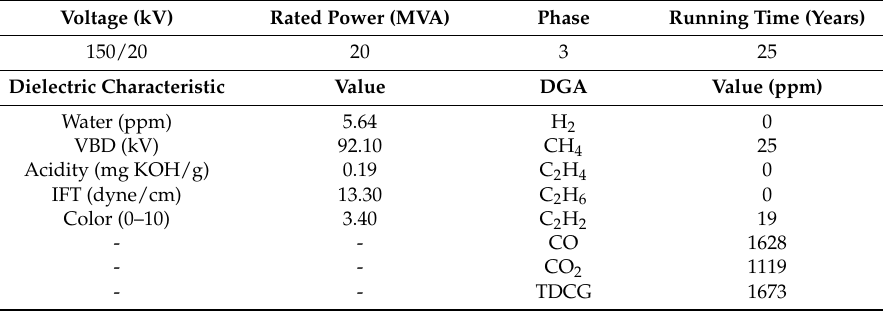
Table 1. Transformer